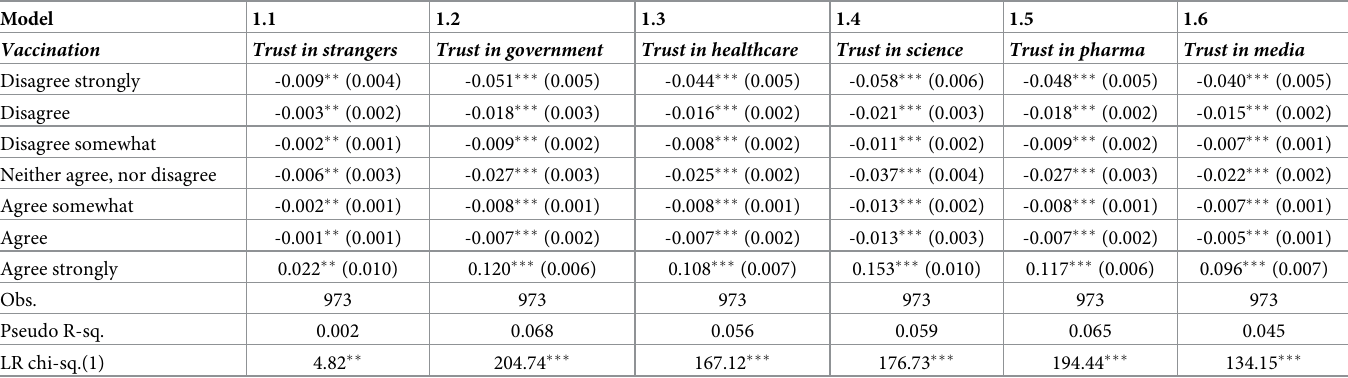
Table 1. Ordered logistic regression model with single trust variable and no